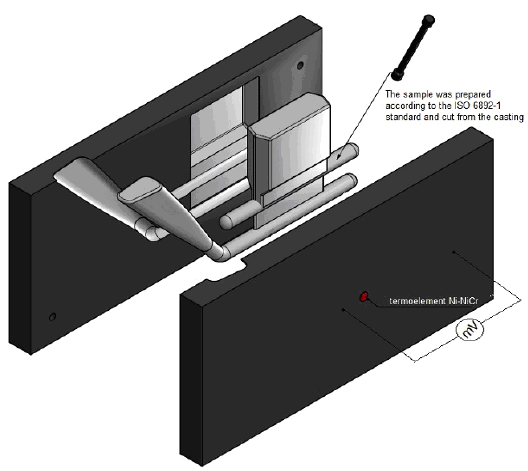
Fig. 1. Metal mould to pouring of the test pieces and controlling of the crystallization process with use of the ATND method